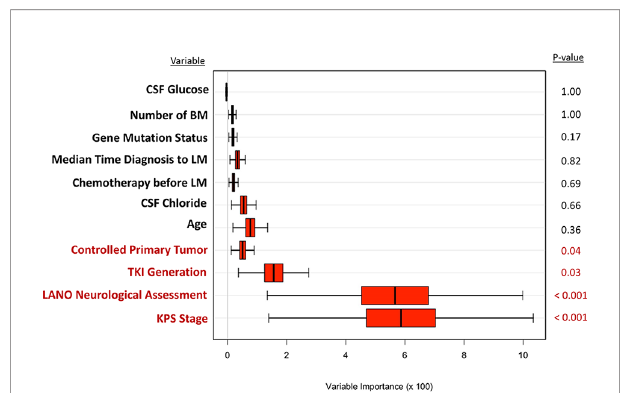
FIGURE 2 | The random forest model for predicting survival of lung adenocarcinoma with LM. LM, leptomeningeal metastases; KPS, Karnofsky performance status; LANO, Leptomeningeal Assessment in Neuro-Oncology; TKI, tyrosine kinase inhibitor; CSF, cerebrospinal fl uid; GPA, Graded Prognostic Assessment.